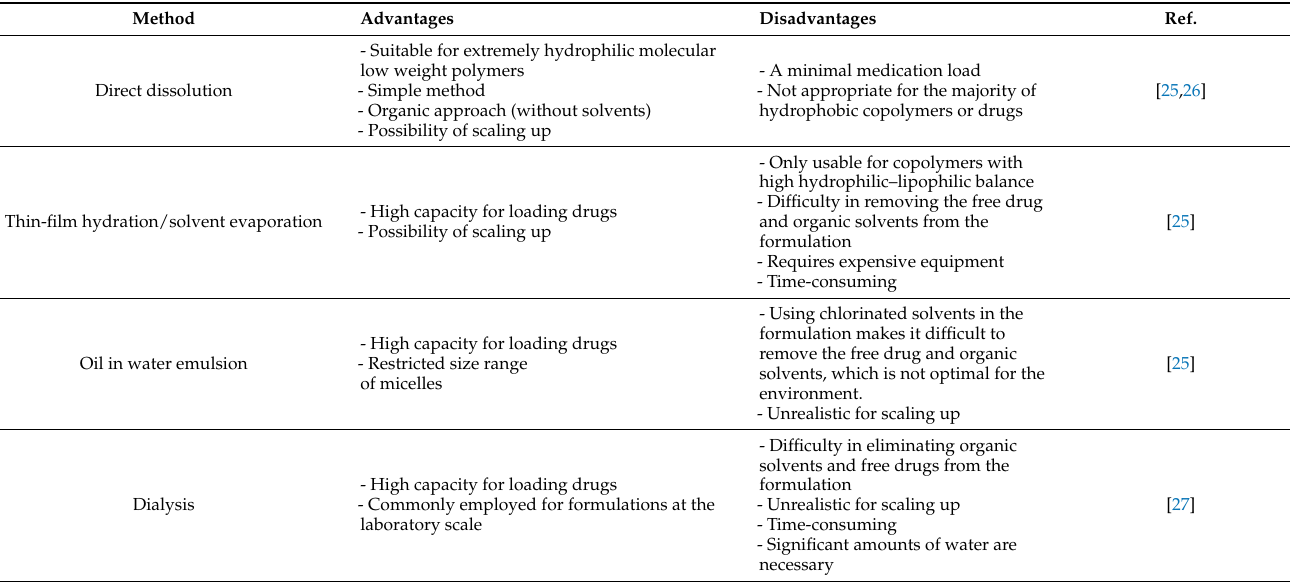
Table 2. Summary of common methods used for obtaining polymeric